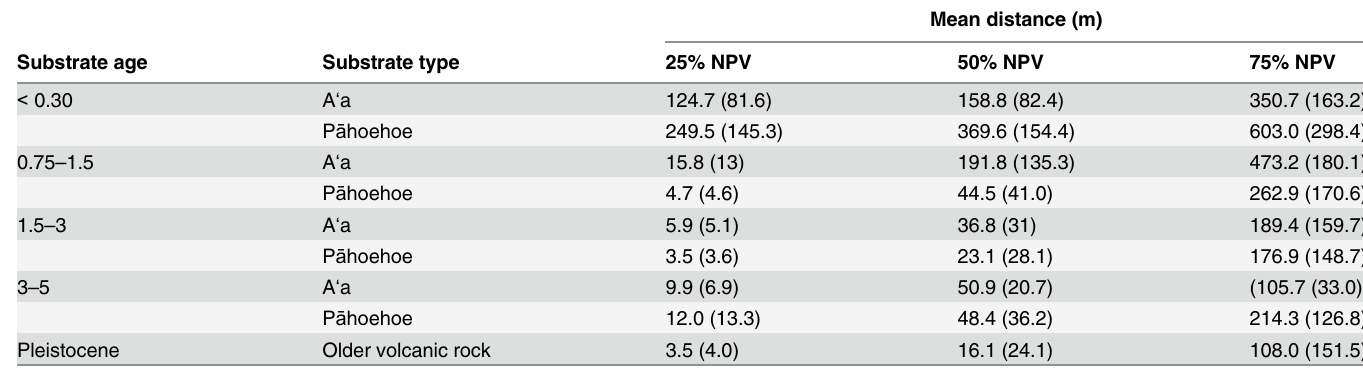
Table 4. Mean distance (m) 2,000 randomly selected locations on substrates of the P ō hakuloa substrate age gradient and the nearest location with at least 25%, 50% or 75% lateral cover of NPV.